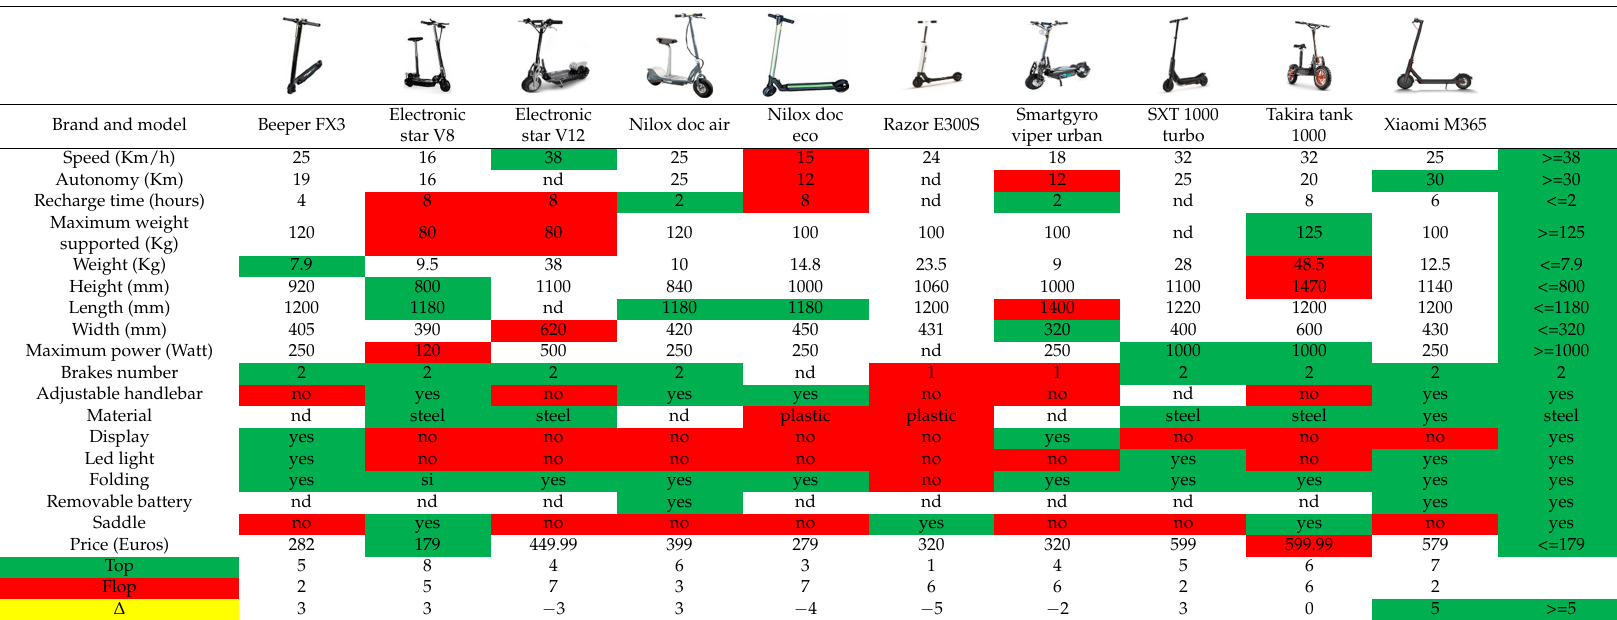
Table 2. Bench Marking Analysis.